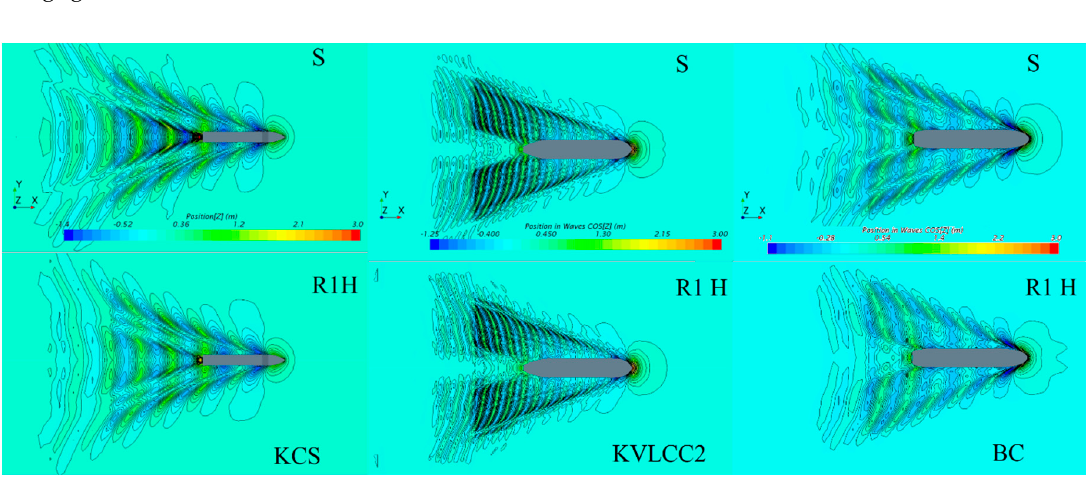
Figure 20. The obtained wave patterns around KCS ( left ), KVLCC2 ( middle ) and BC ( right ).